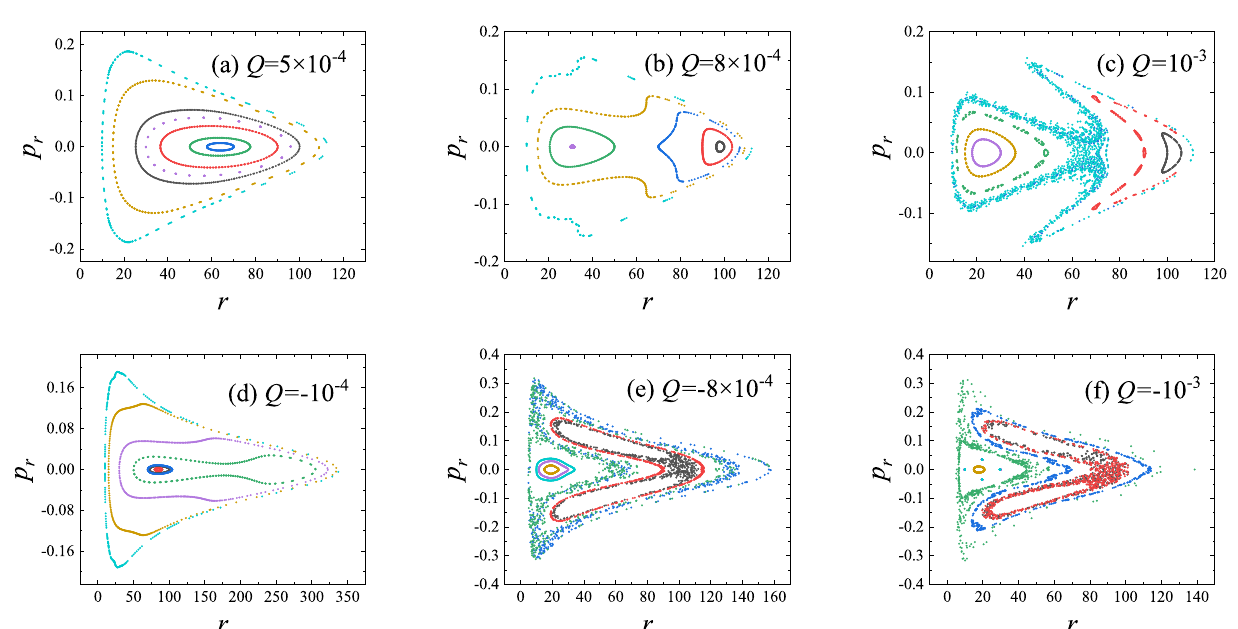
Figure 5. Poincaré sections for different values of the magnetic parameter Q . The other parameters are L = 4, k 0 = 10 − 4 , k 1 = 10 − 2 , k 2 = 10 − 1 and k 3 = 1. ( a – c ): E = 0.9915 and Q > 0; the strength of chaos is enhanced with increasing Q . ( d – f ): E = 0.9975 and Q < 0; chaos is strong as | Q | increases.